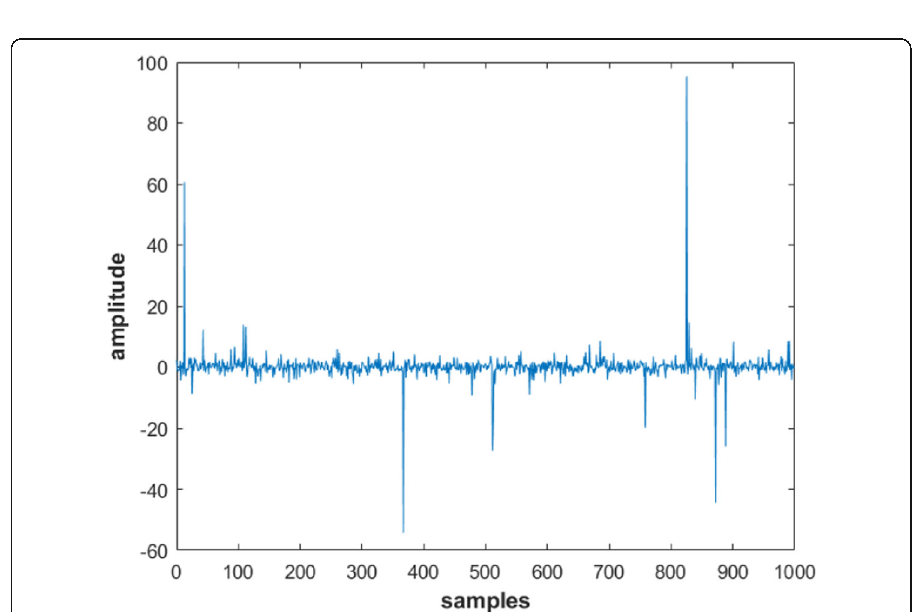
Fig. 2 S α S distributed signal with α =